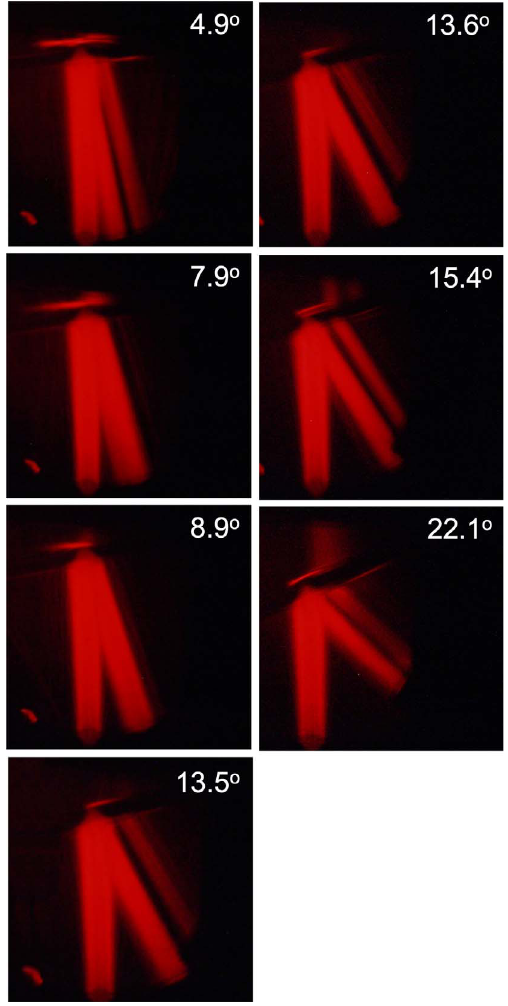
Figure 4. Schlieren photographs of Schoch effect on sample 2.